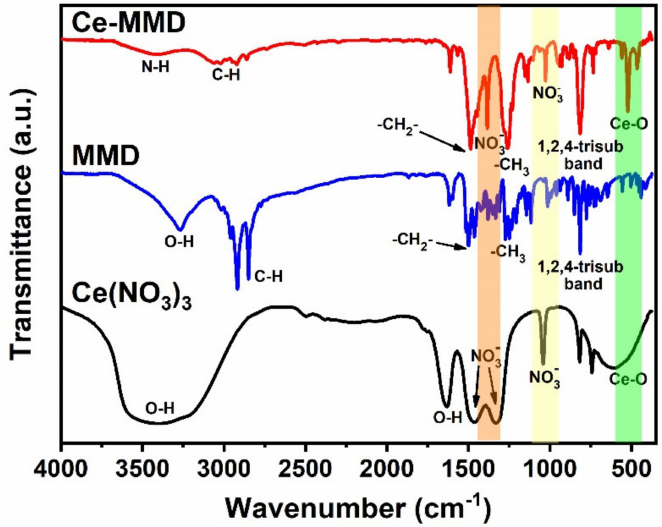
Figure 8. FTIR spectra of cerium(III) nitrate hexahydrate, the MMD ligand, and the Ce-MMD